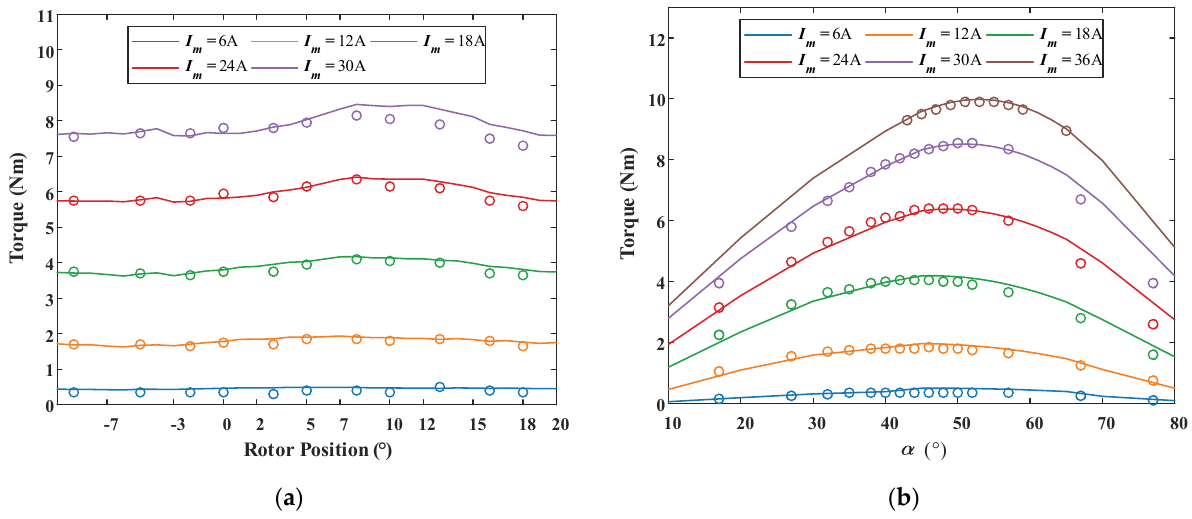
Figure 16. Measured torque vs. current phases and rotor positions.